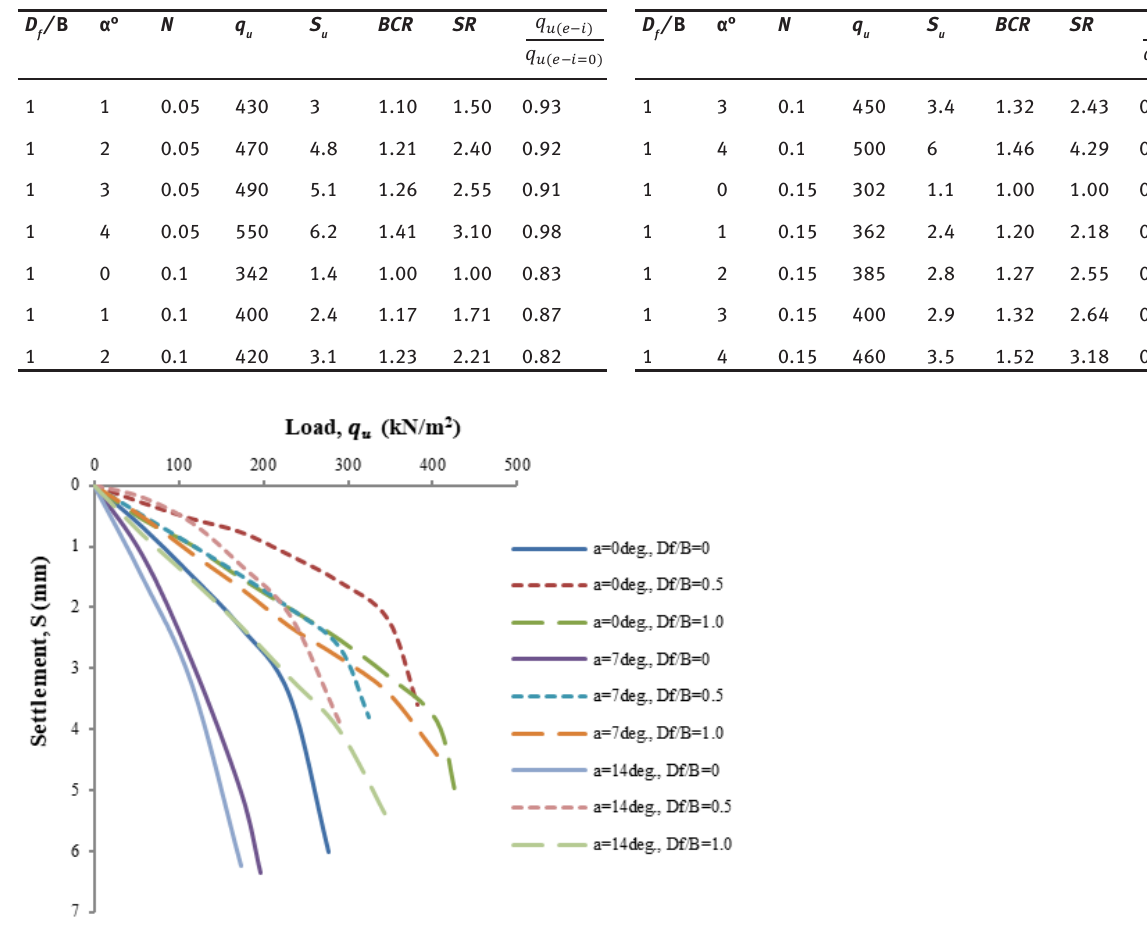
Figure 6(b): Variation of L–S curve for inclined loading with an embedment depth D